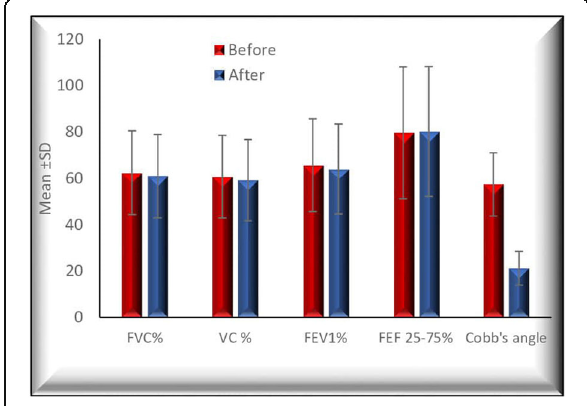
Fig. 3 Pulmonary function test and Cobb ’ s angle changes before and after surgery